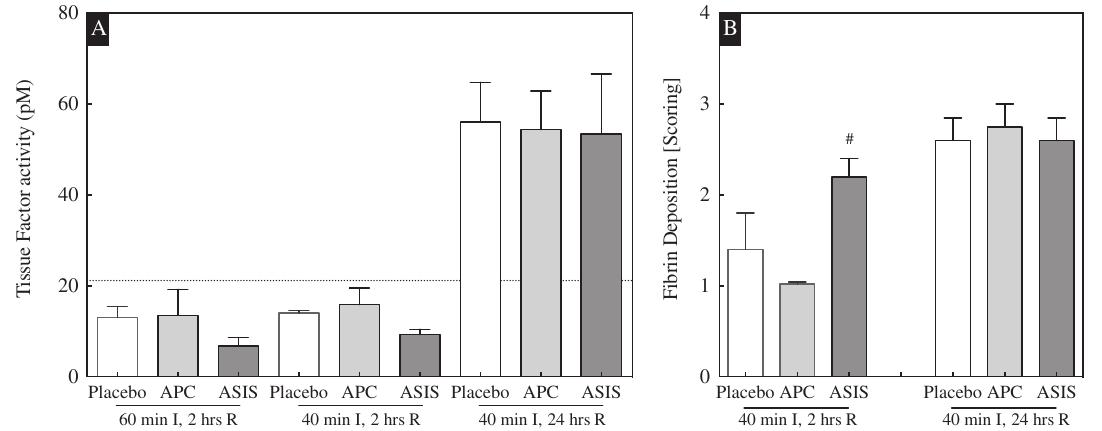
Figure 3. Panel A: TF activity levels decreased after ASIS administration but were not in fl uenced upon APC administration. Panel B: fi brin deposition increased after 24 hr of reperfusion but was not in fl uenced upon APC or ASIS administration. Values are mean ± SEM, n = 10, # ASIS vs. placebo p <